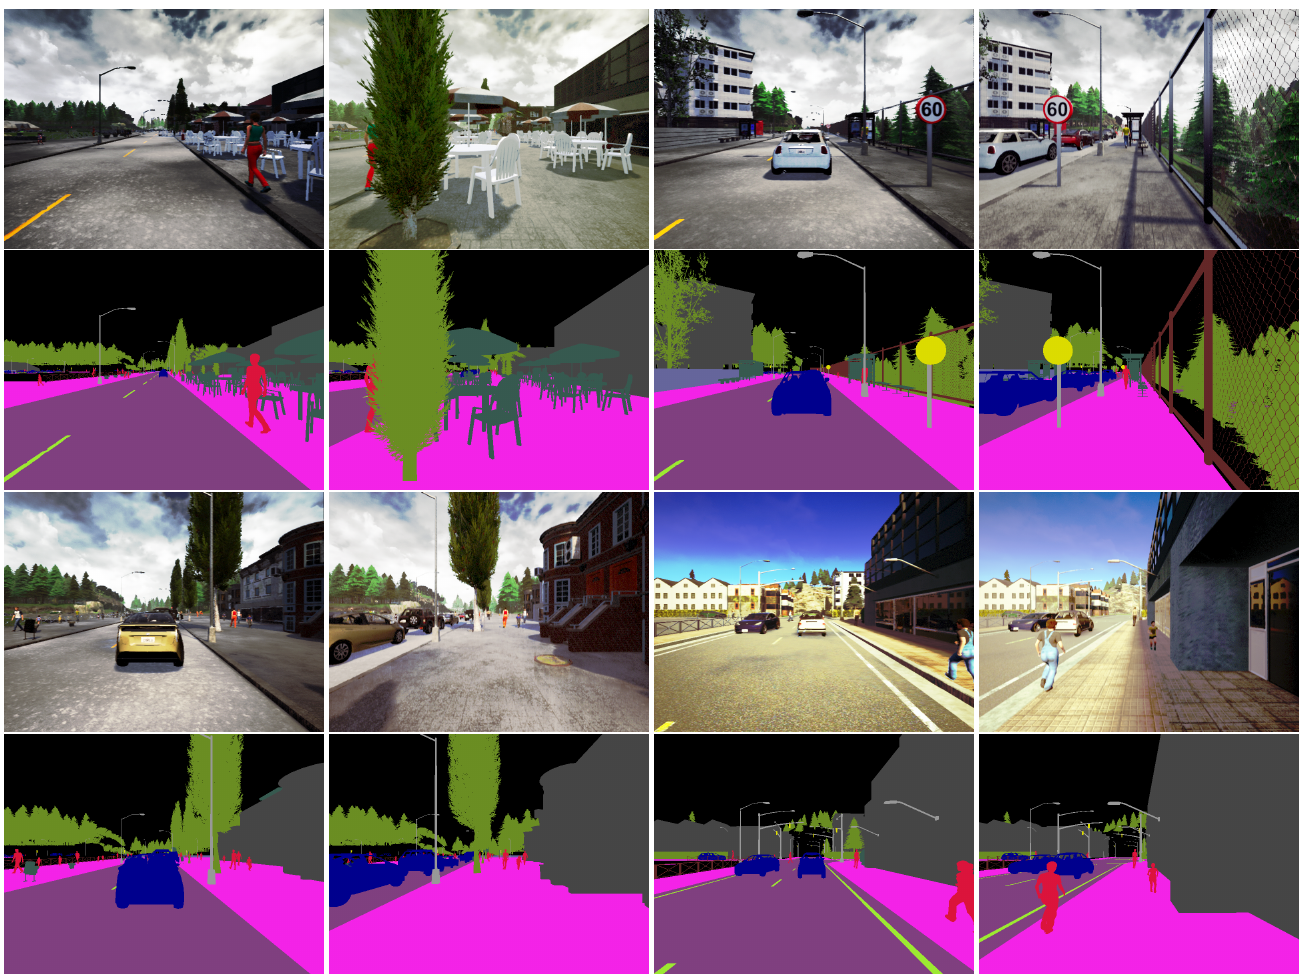
Figure 2. Four examples of couple-images from the additional dataset, taken from a viewpoint located on the road (left of each couple) and from a viewpoint located on the sidewalk (right of each couple). AT the couple of each couple-images, the true classes of the semantic segmentation are